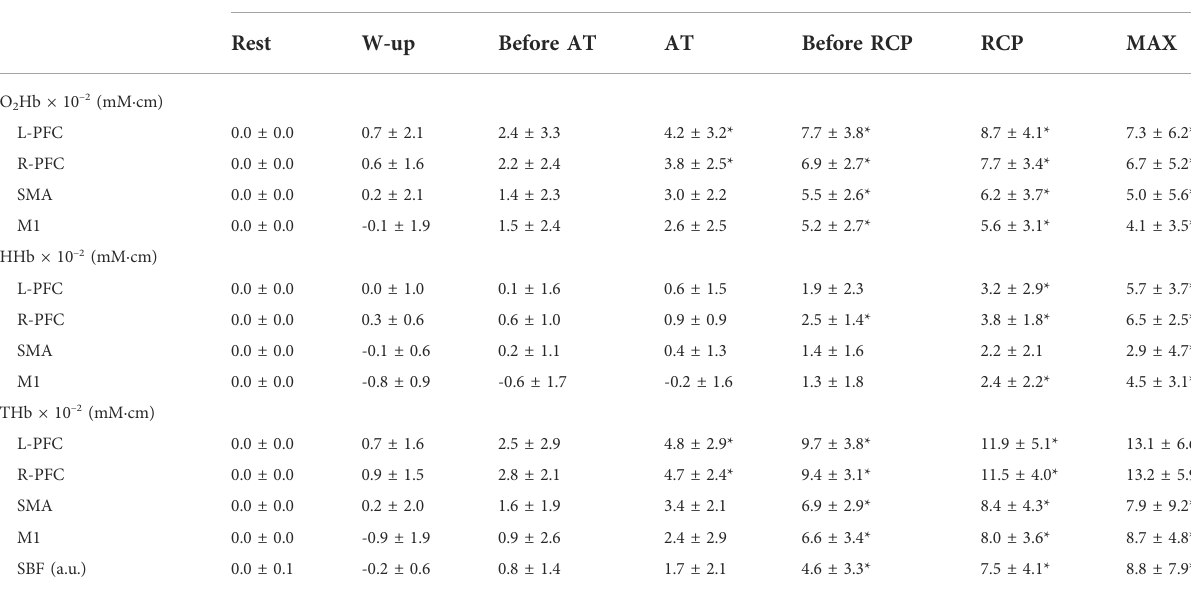
TABLE 2 Changes in cerebral oxygenation and skin blood fl ow based on respiratory metabolism. Variable Time Rest W-up Before AT AT Before RCP